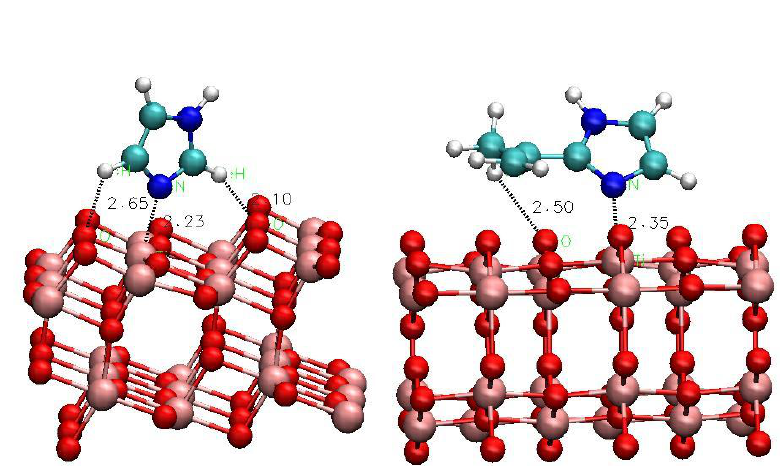
Figure 4 . Selected adsorption configurations of (left to right)